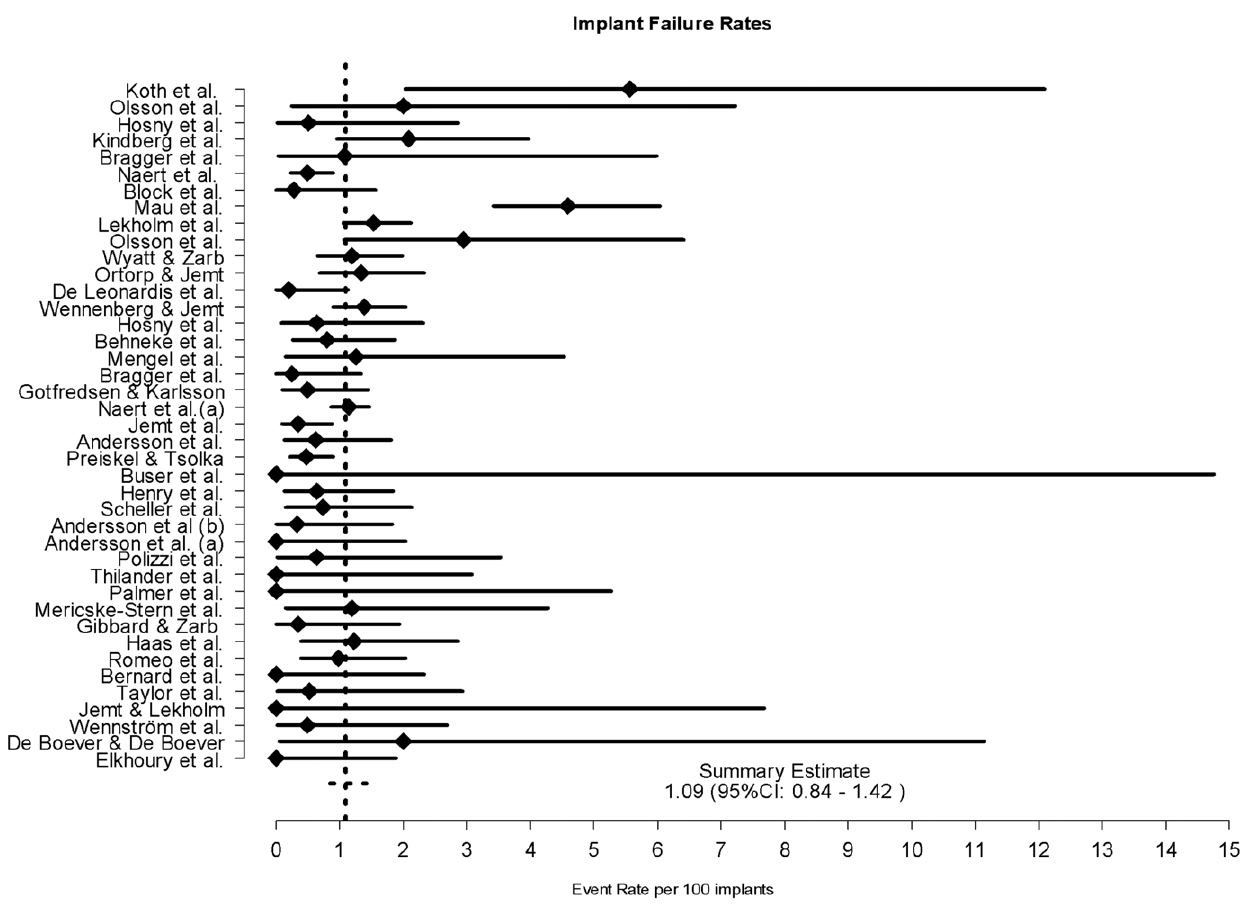
Figure 3. Annual percentages of failures. doi:10.1371/journal.pone.0010274.g003 Table 2. Regression quasi-Poisson univariate and multivariate models of the effects of independent variables on the annual failure rate of dental